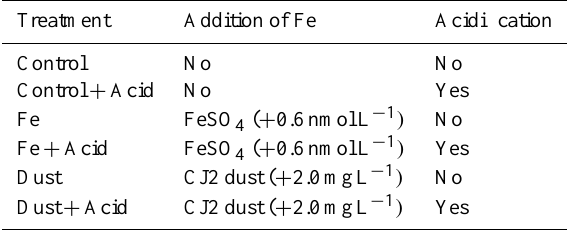
Table 1. Description of Fe or dust additions and acidification status of each treatment. All treatments were conducted in